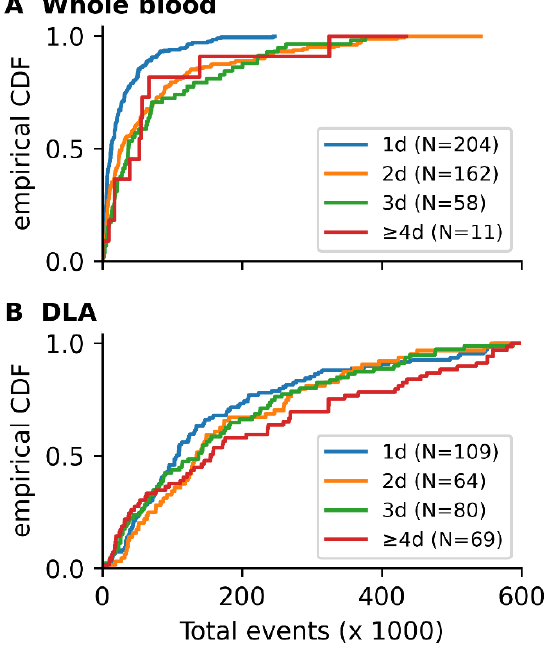
Figure 4. Cumulative distribution functions (CDF) of (A) blood and (B) DLA samples with different collection to prep intervals. ( A ) The cumulative distribution functions of samples with one, two, three, and four+ days (d) between blood draw and sample preparation show a clear increase in cell density for time intervals of more than one day in ( A ) whole blood and ( B ) DLA samples. While a dependence of the number of events on the time from sample collection to sample preparation may also be observed in DLA samples, the difference is less pronounced than in blood.